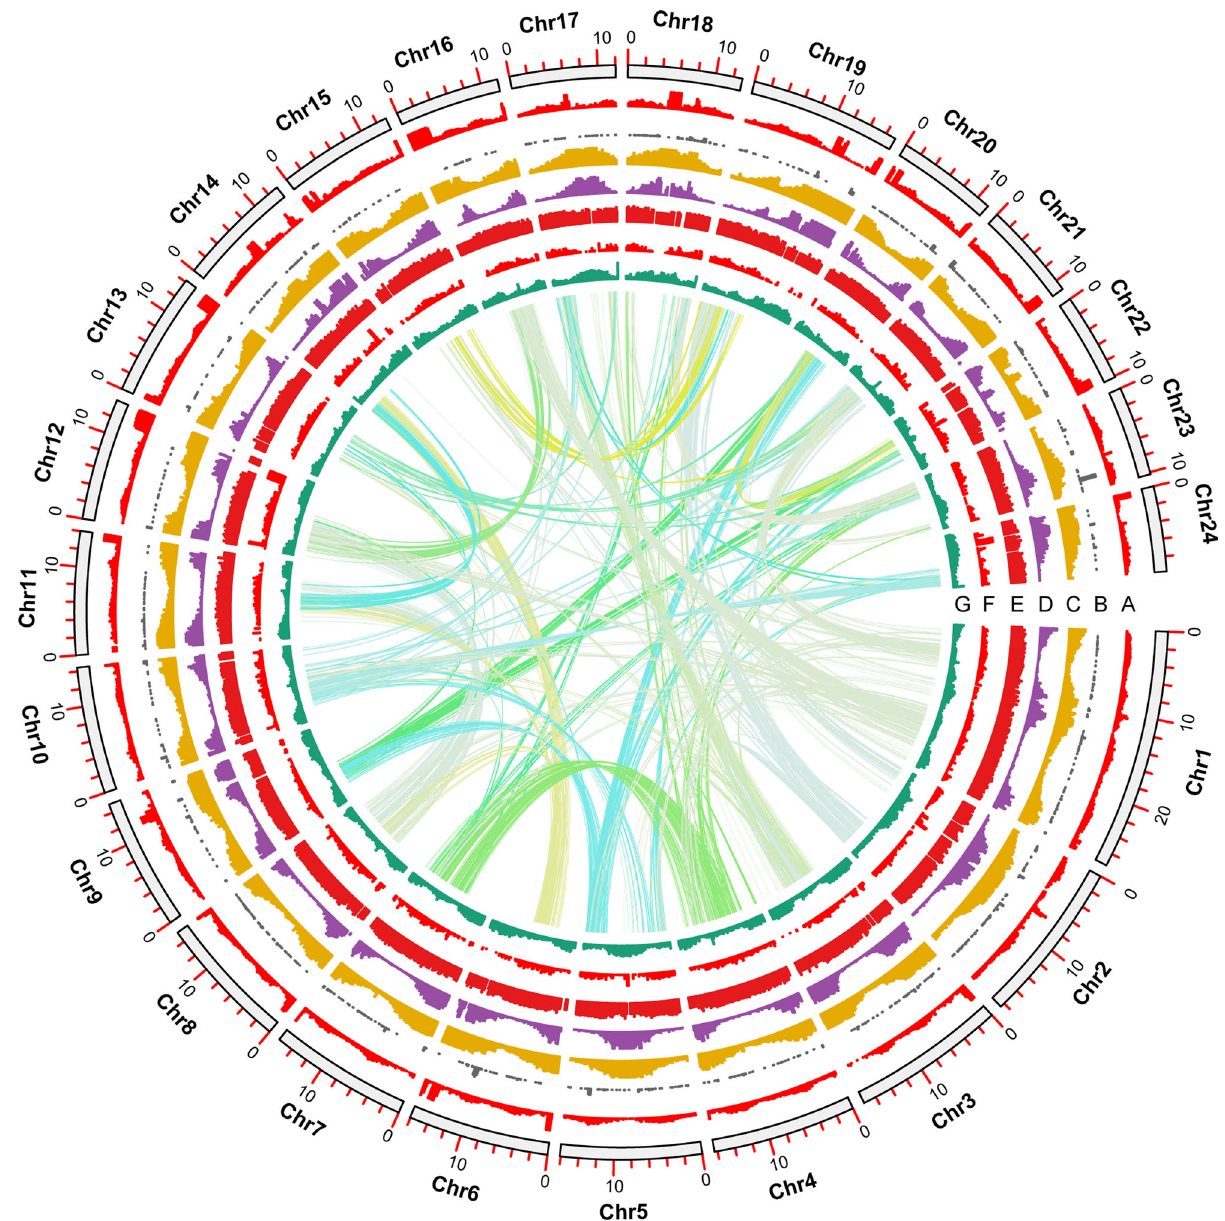
Fig. 1 Overview of the A. fasciata genome. a DNA Retrotransposon coverage. b Pseudogene distribution density. c Repeat sequence coverage. d RNA retrotransposon coverage. e Gene expression level. f Gene density. g GC content. The genome features are shown in 1 Mb intervals. The gene expression levels were normalized to the RPKM